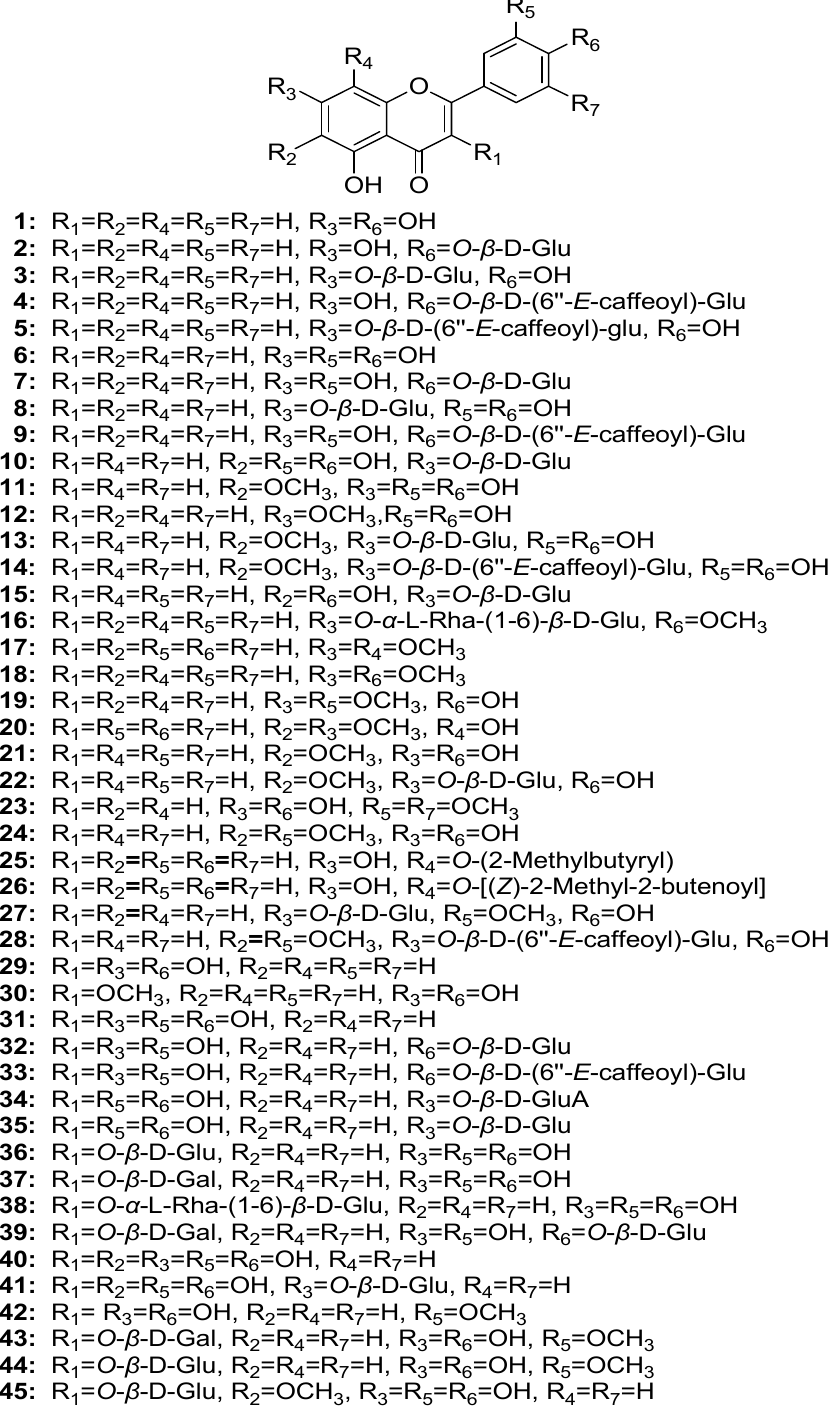
Figure 1. Chemical structures of flavonoids isolated from the genus Gnaphalium